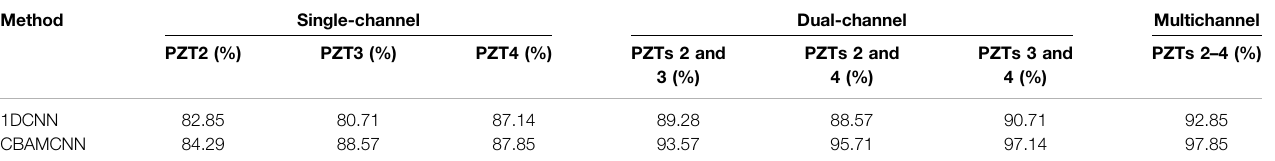
TABLE 2 | Recognition result of the 1DCNN and CBAMCNN models.